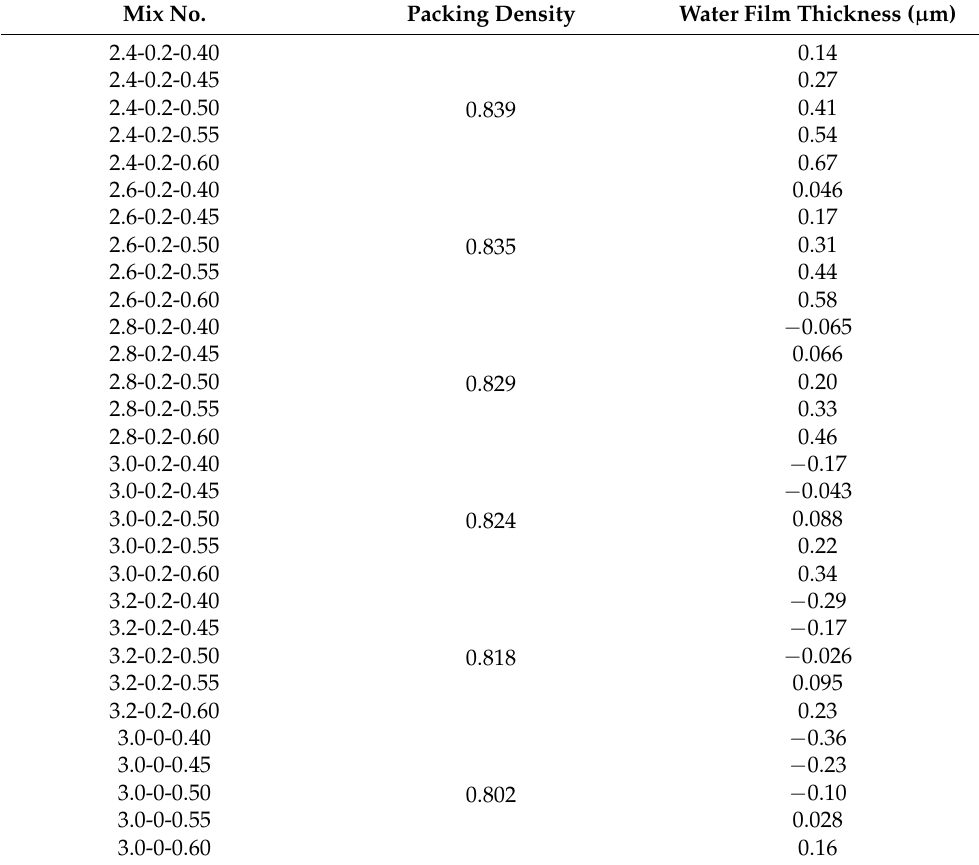
Table 3. Packing density and WFT results. Mix